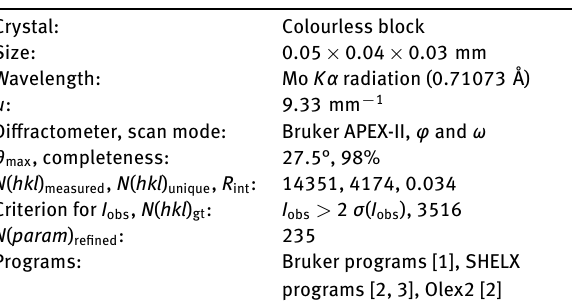
Table 1: Data collection and